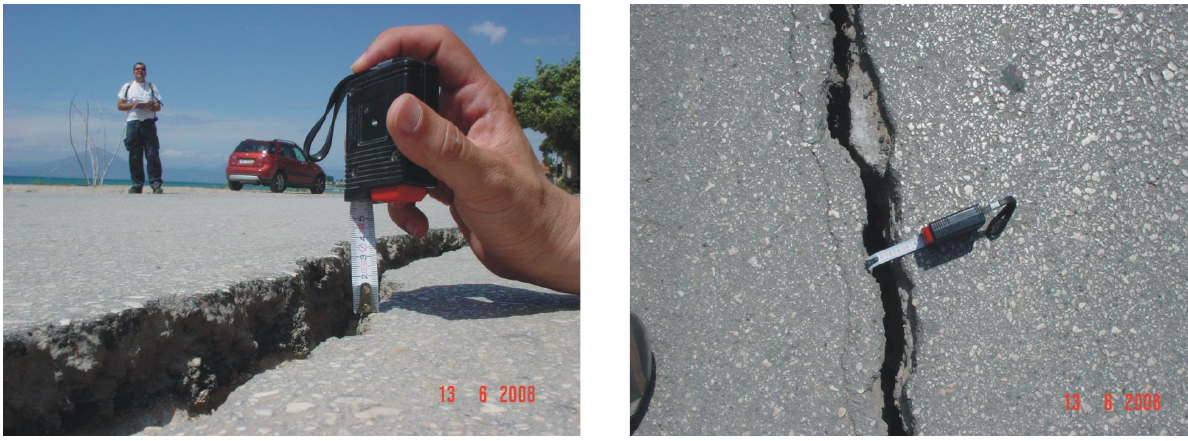
Figure 9. Structural damages at the waterfront area of the village Vrahneika. Examples of failures on pavement with both throw and open- ing components (left: throw = 3 cm and opening = 2 cm; right: opening = 4 cm).